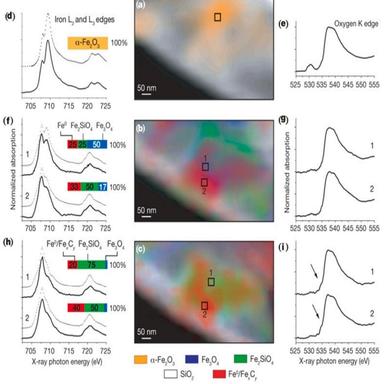
Chemical contour maps (a, b, c) of a 400 nm × 750 nm region and corresponding Fe L2-edge and L3-edge (d, f, h) and O K-edge (e, g, i) XAS. (a) Before treatment, at room temperature (25 ◦C) in helium. (b) after 2 h in H2 at 350 ◦C. (c) after 4 h in synthesis gas at 250 ◦C. The dotted lines in (d, f, h) indicate the spectra fitted by a linear combination of reference spectra.